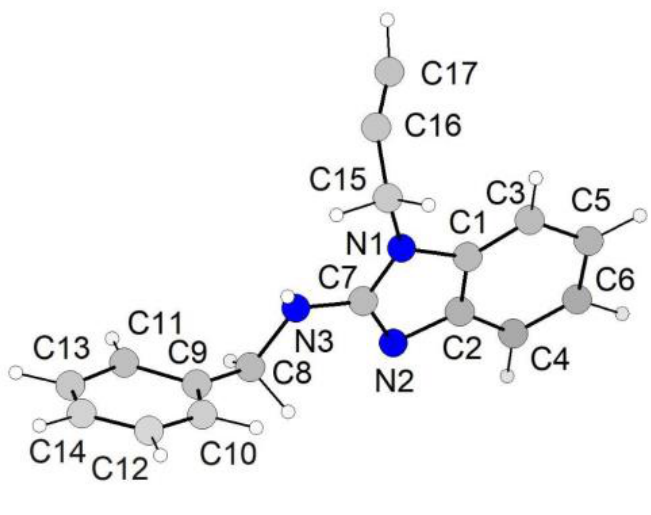
Figure 1. Crystal structure of C 17 H 15 N 3 [57]. Table 1. Crystal data, Rietveld refinement parameters and CCDC [63] depository number for C 17 H 15 N 3 [60]. Formula, formula weight